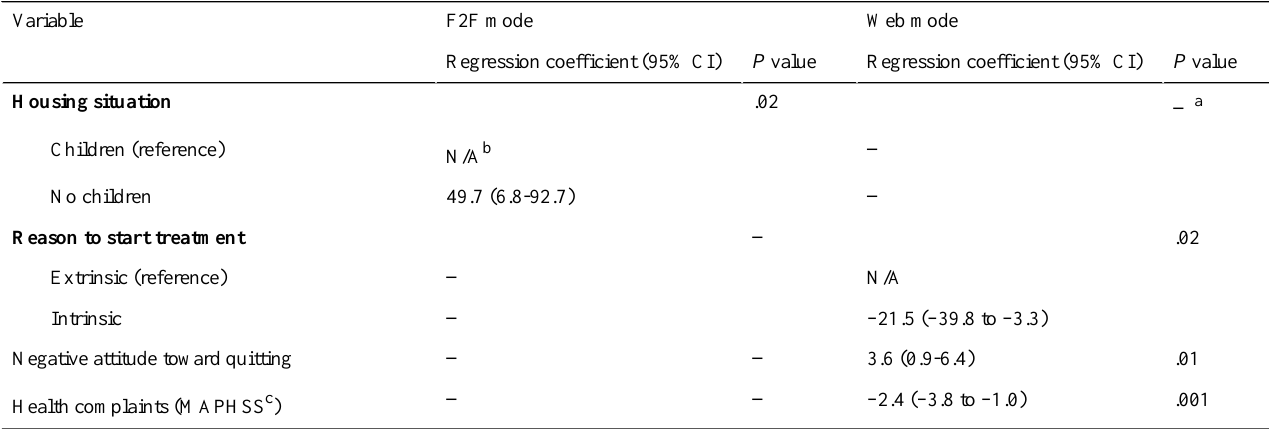
Table 7. Multivariate model of patient characteristics predicting adherence to face-to-face (F2F) and web mode in the blended treatment group.